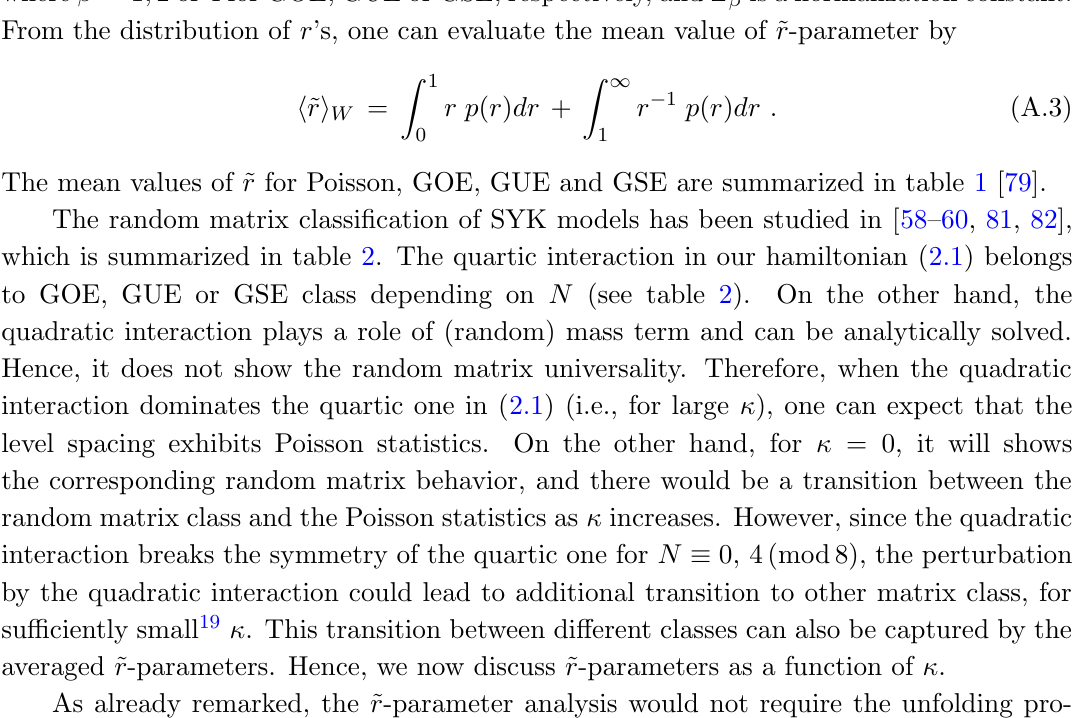
is a normalization (cid:12)